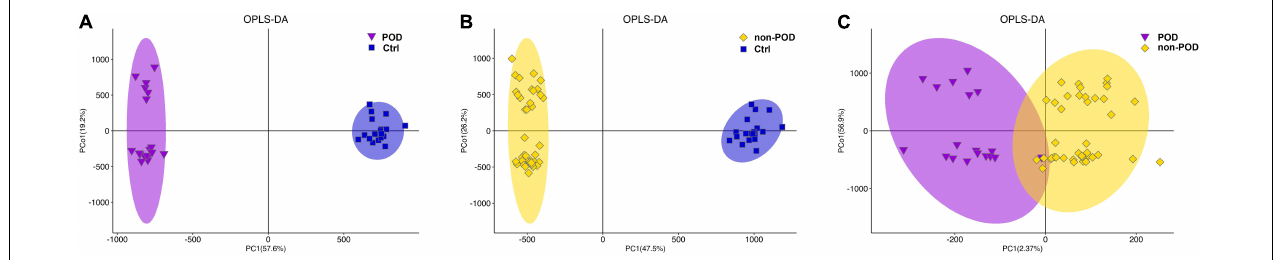
FIGURE 2 | Orthogonal partial least squares discriminant analysis (OPLS-DA) score plot reveal the overall distribution of serum samples in POD and non-POD group. (A) OPLS-DA of metabolomics data from POD and healthy controls. (B) OPLS-DA of metabolomics data from non-POD and healthy controls. (C) OPLS-DA was used to distinguish differentially expressed metabolites (DEMs) between POD and non-POD group. The indicated groups are presented by different colors (blue: Ctrl; purple: POD; yellow: non-POD). POD: post-operative delirium. non-POD: non-post-operative delirium. Ctrl: healthy controls.